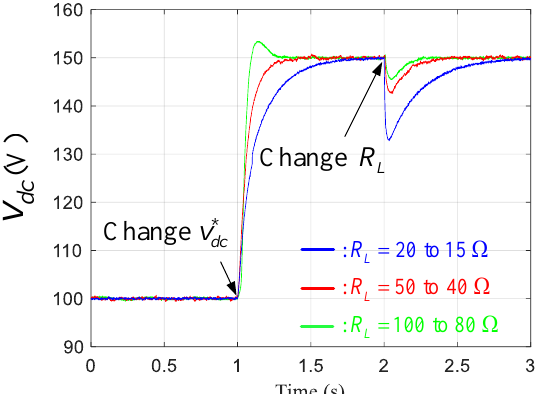
Figure 4. Operating conditions for the experiments under healthy